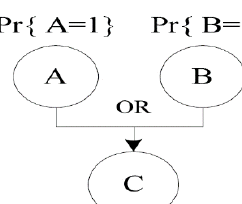
Figure 3. Bayesian network related to the fault tree with OR